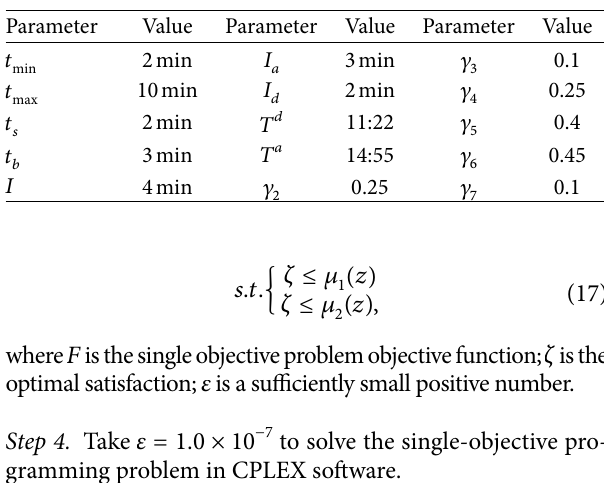
Figure 3: Railway network structure of the Nanjing South-Shanghai Hongqiao Table 2: The parameter values.